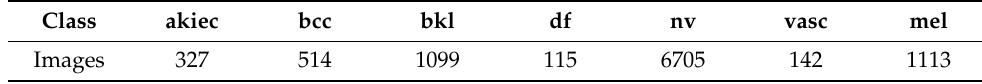
Table 1. Class-wise images present in HAM10000